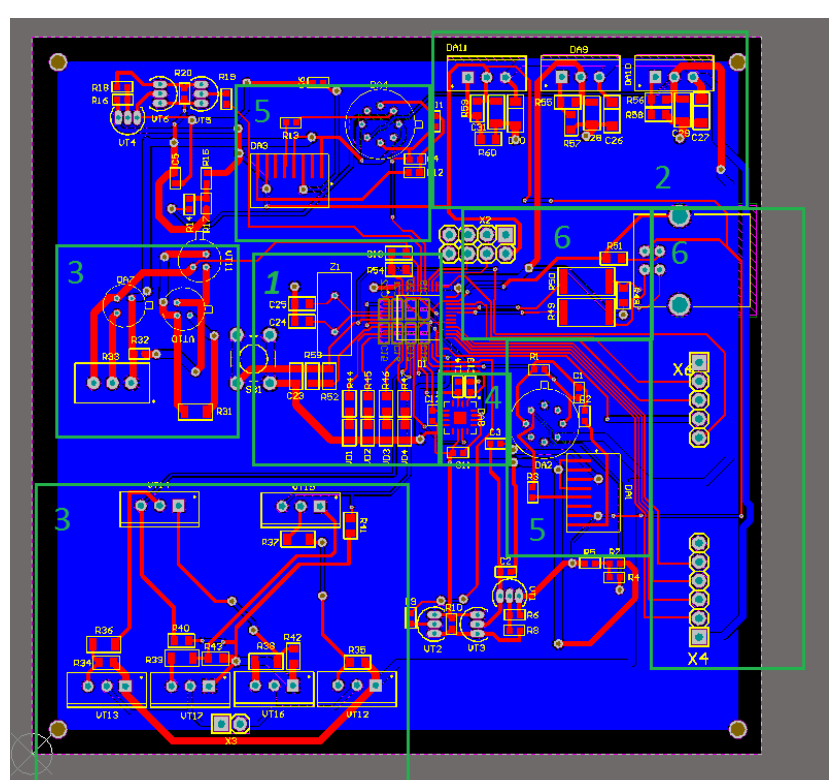
Fig. 1. Wiring diagram of the prototype inertial positioning system.